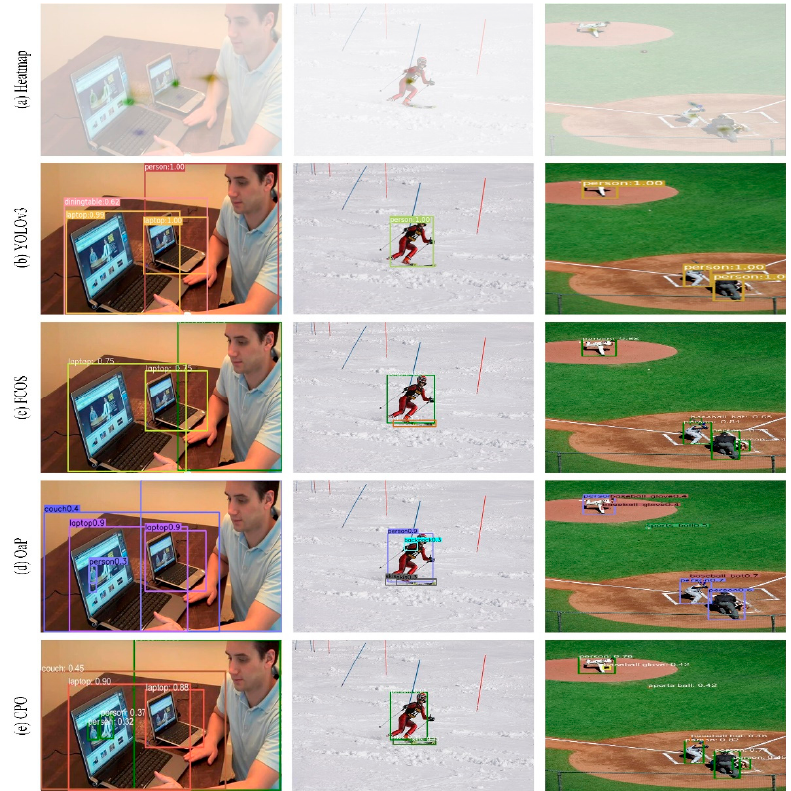
Figure 7. Experimental test results. ( a ) Heatmap output result. ( b ) YOLOv3 detector test result. ( c )